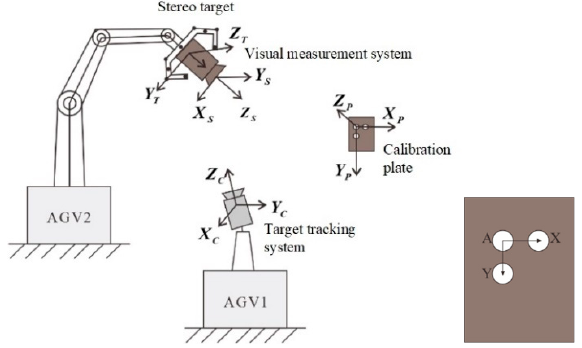
Figure 6. System calibration principle.